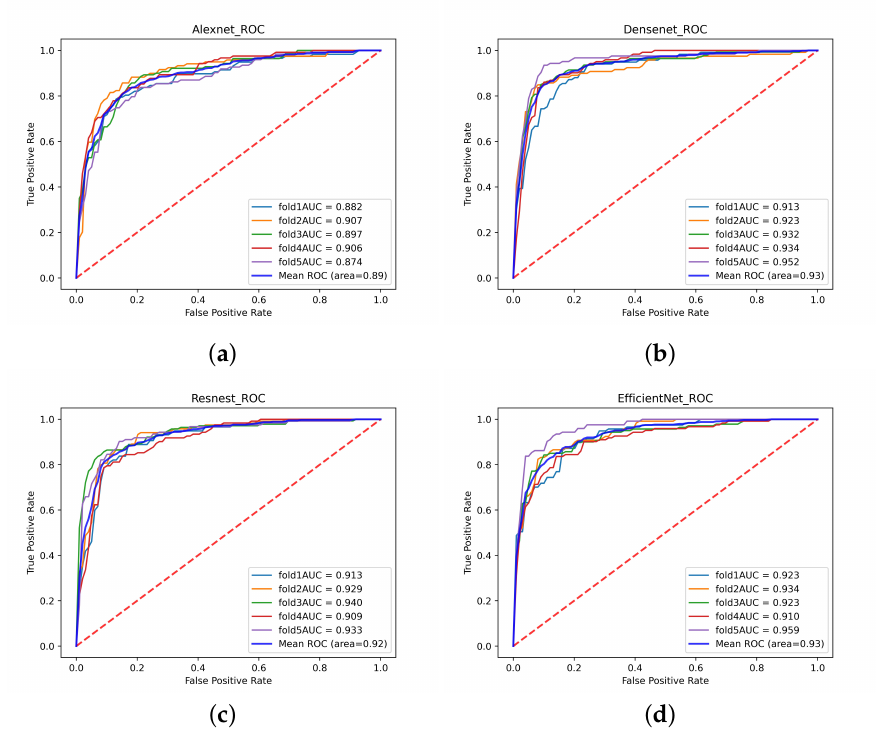
Figure 13. The receiver operating characteristic curve (ROC) curve of the single-modal data set.